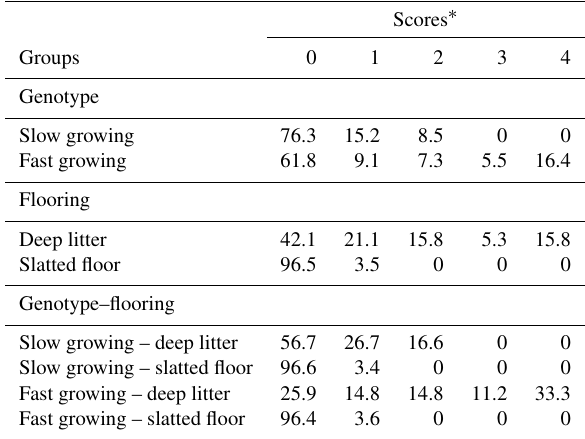
Table 1. Prevalence of foot-pad dermatitis in the experimental groups at the end of the experiment (%).